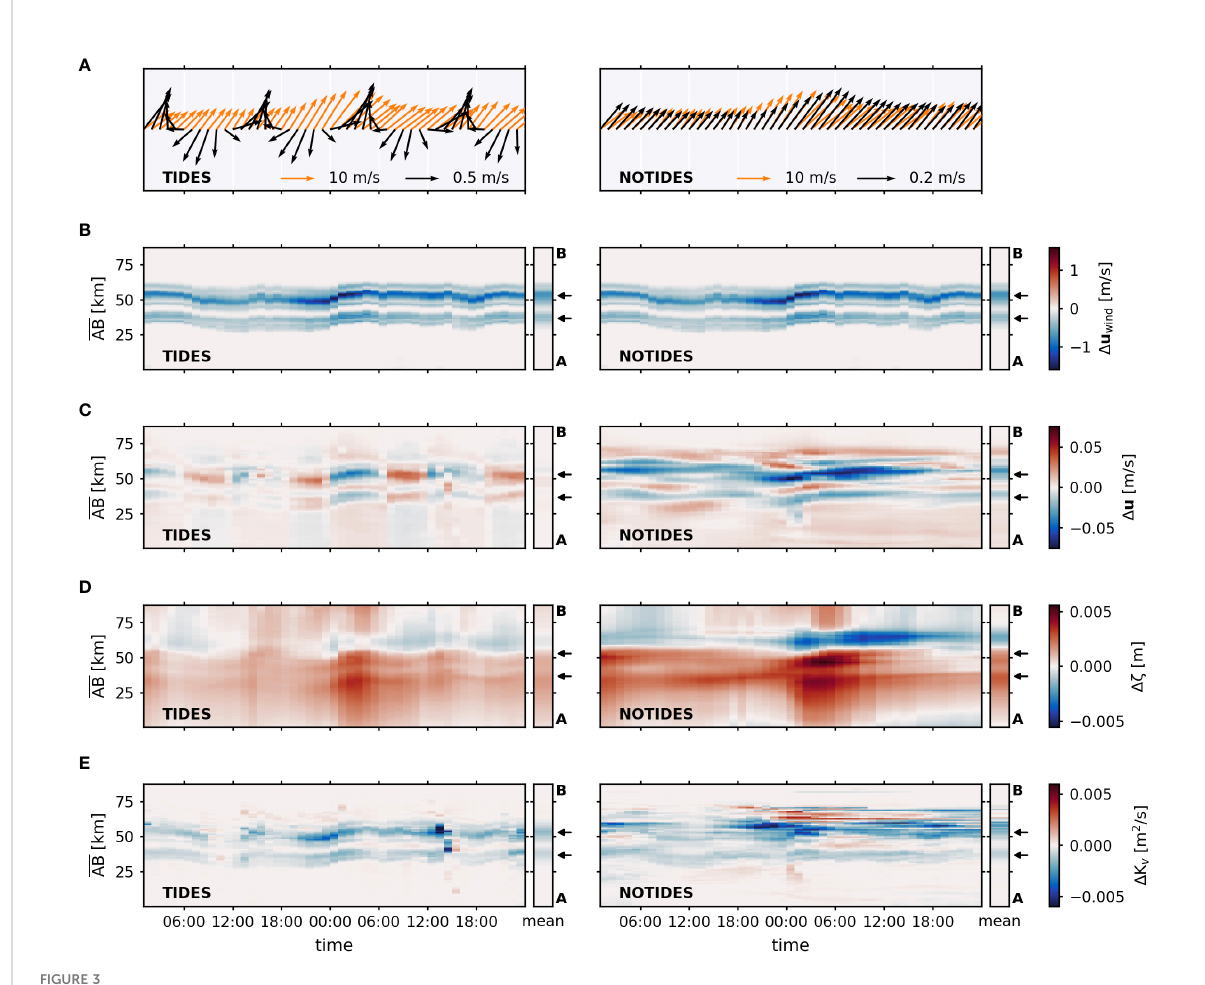
FIGURE 3 Wake effects along the pro fi le AB (see Figure 2) for TIDES (left) and NOTIDES (right) between May 9 and May 11. (A) Vectors of the mean wind direction (orange) and the mean depth-averaged horizontal currents (black) along the pro fi le, indicating the wind-ocean alignment. In addition, Hovmöller diagrams and temporal mean changes along pro fi le AB are depicted for the relative differences in wind speed u (B) , horizontal surface velocity u (C) , sea surface elevation z (D) and surface eddy diffusivity K v (E) . Black arrows indicate the mean location of the wind wake